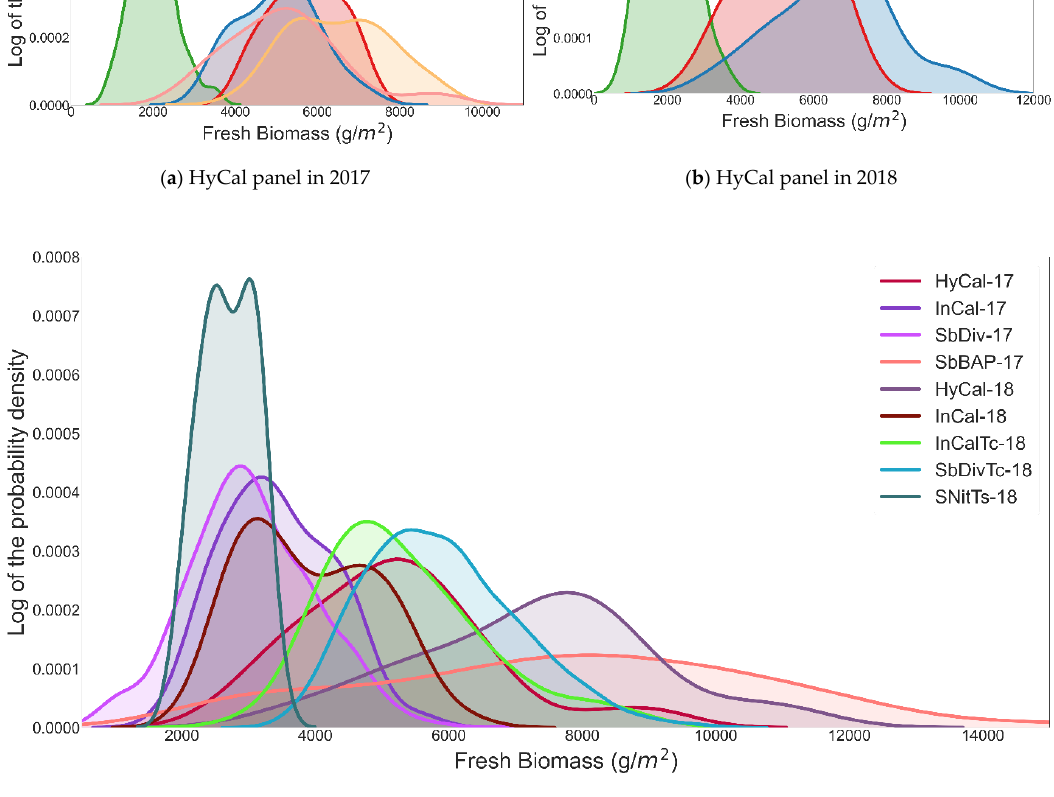
Figure 2. Distribution of the fresh biomass data in the nine trials in the 2017 and 2018 growing seasons.